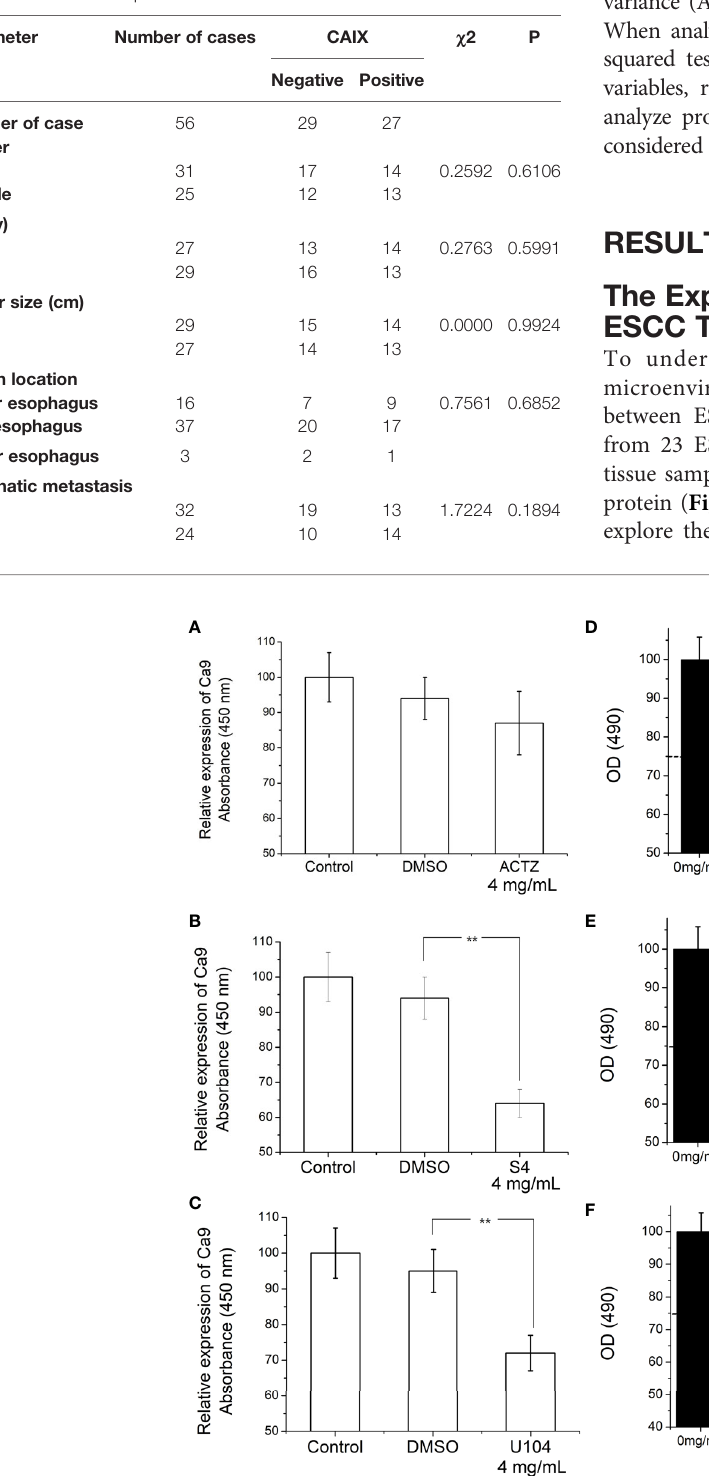
TABLE 1 | Association between CAIX expression and clinicopathological characteristics of ESCC